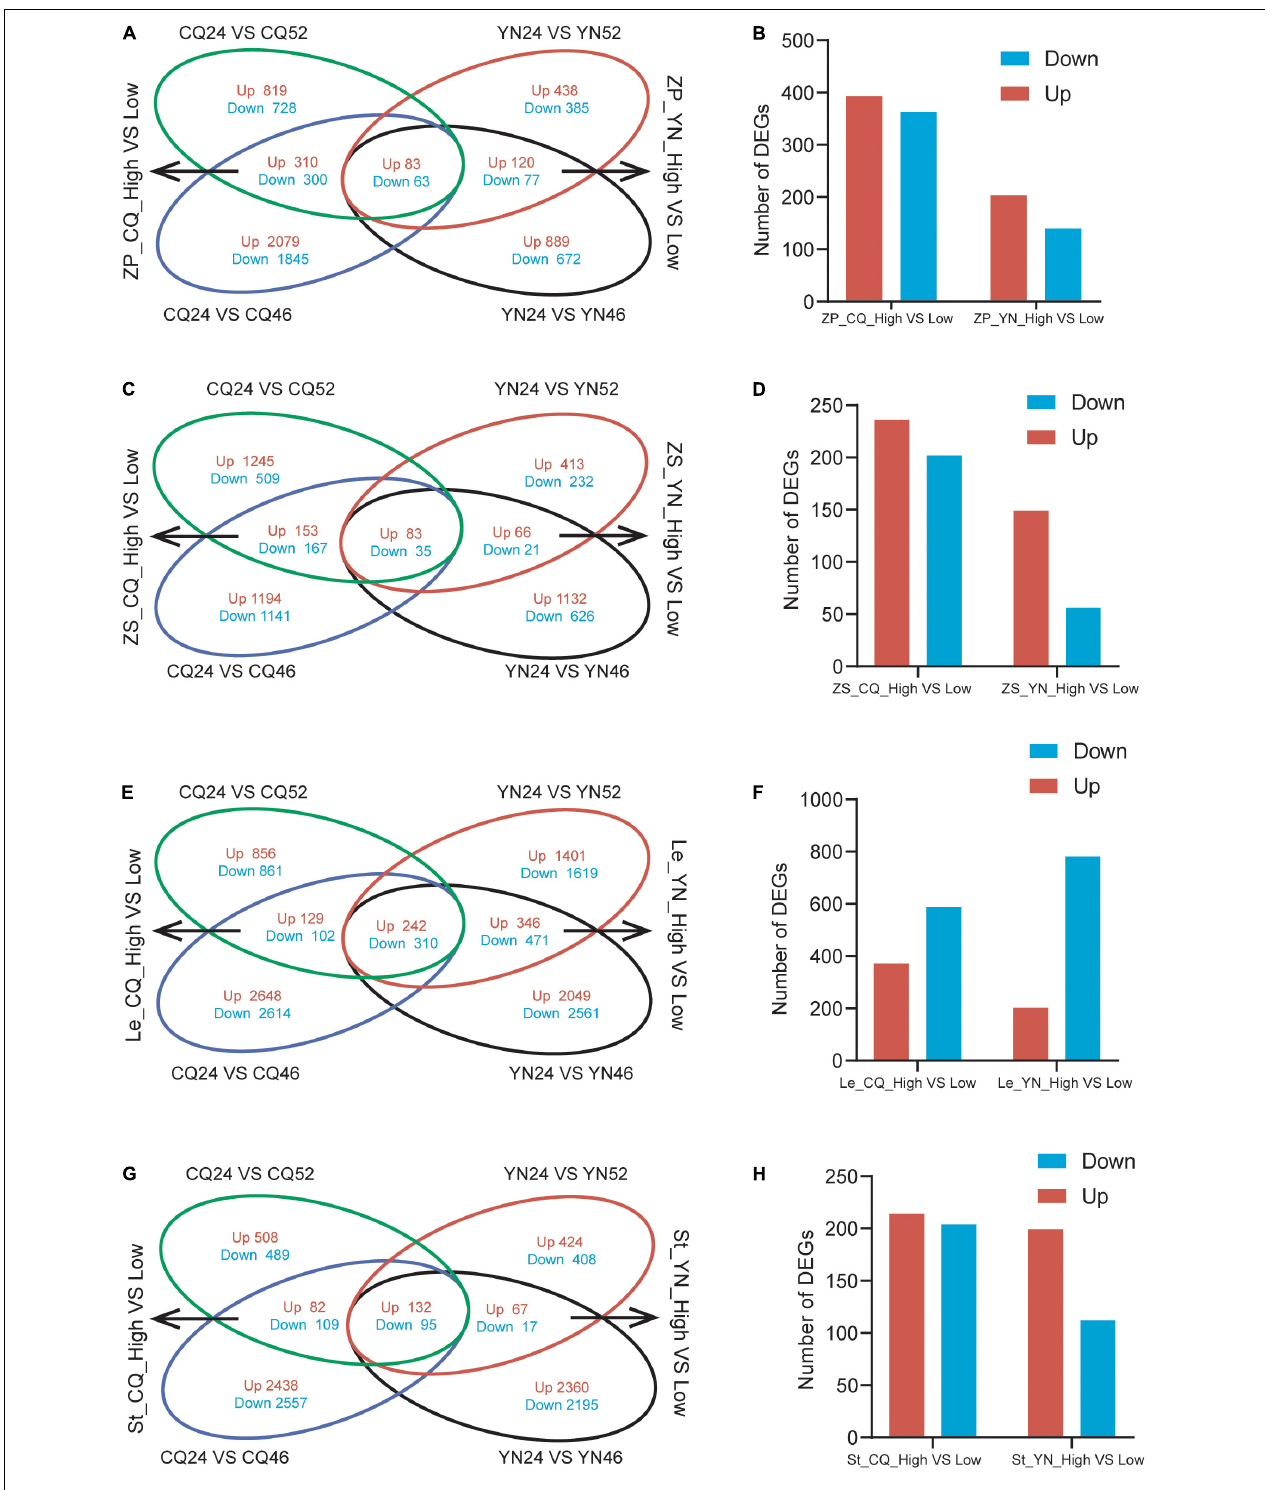
FIGURE 1 | Venn diagrams and the number of DEGs of the DEGs from high- and low-HI accessions. (A) A Venn diagram of DEGs between high- and low-HI accessions in ZP at CQ and YN. (B) The number of DEGs between high- and low-HI accessions in ZP. (C) A Venn diagram of DEGs between high- and low-HI accessions in Le at CQ and YN. (D) The number of DEGs between high- and low- HI accessions in Le. (E) A Venn diagram of DEGs between high- and low-HI accessions in ZS at CQ and YN. (F) The number of DEGs between high- and low-HI accessions in ZS. (G) A Venn diagram of DEGs between high- and low-HI accessions in ST at CQ and YN. (H) The number of DEGs between high- and low-HI accessions in ZP in ST.